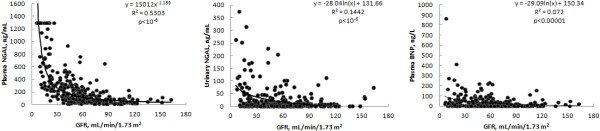
Correlations with glomerular filtration rate of plasma and urinary neutrophil gelatinase-associated lipocalin and plasma B-type natriuretic peptide. Regression lines, regression equations, coefficients of determination R2, and statistical significance of the correlations are reported. BNP, B-type natriuretic peptide; GFR, glomerular filtration rate; NGAL, neutrophil gelatinase-associated lipocalin.